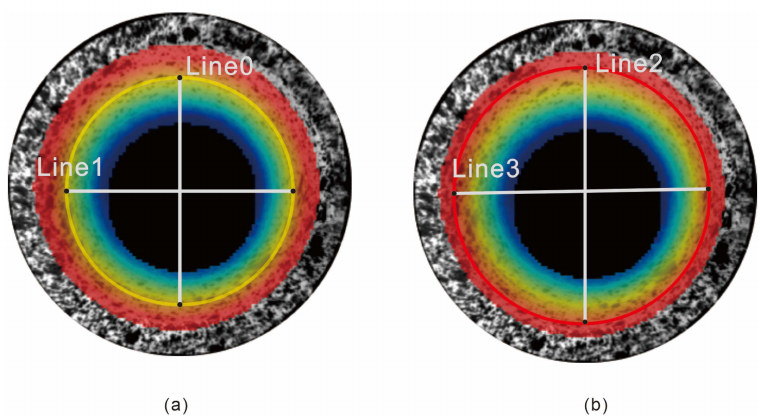
Figure 9. Random diameters at different depths: ( a ) 24 mm; ( b ) 30